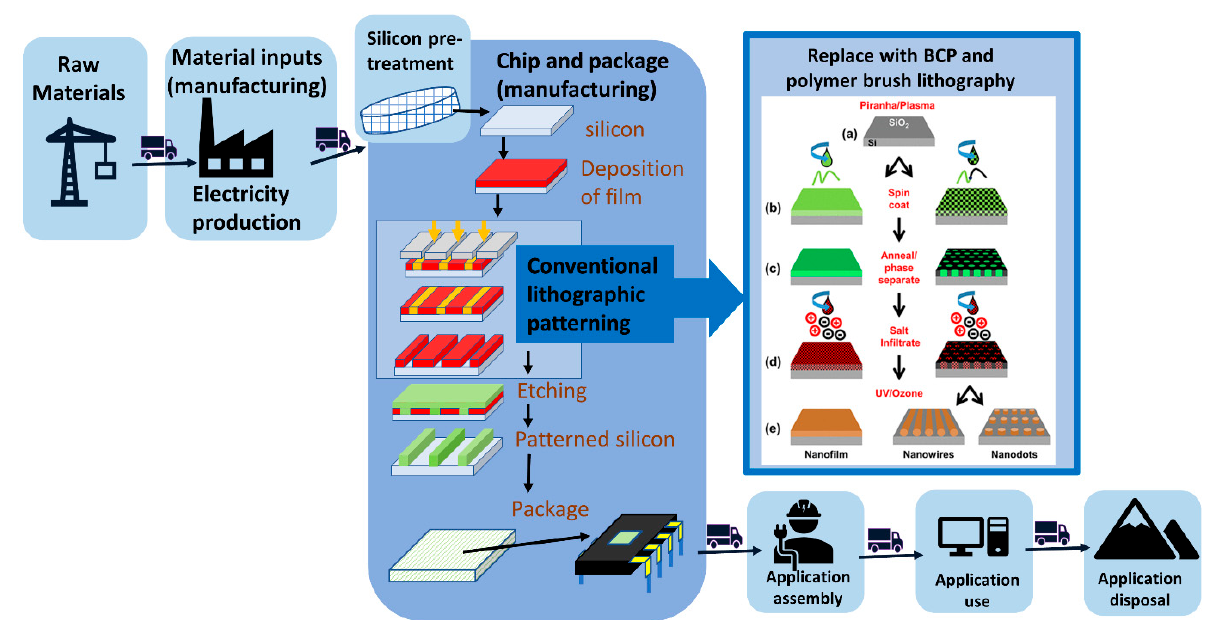
Figure 9. The semiconductor life cycle and the stage in which BCP and brush lithography could be implemented in the life cycle. The stages of the process are adapted from Figure 5: The general phases in a component life cycle [46]. Emerging lithographic sages are adapted from Figure 4 [18].